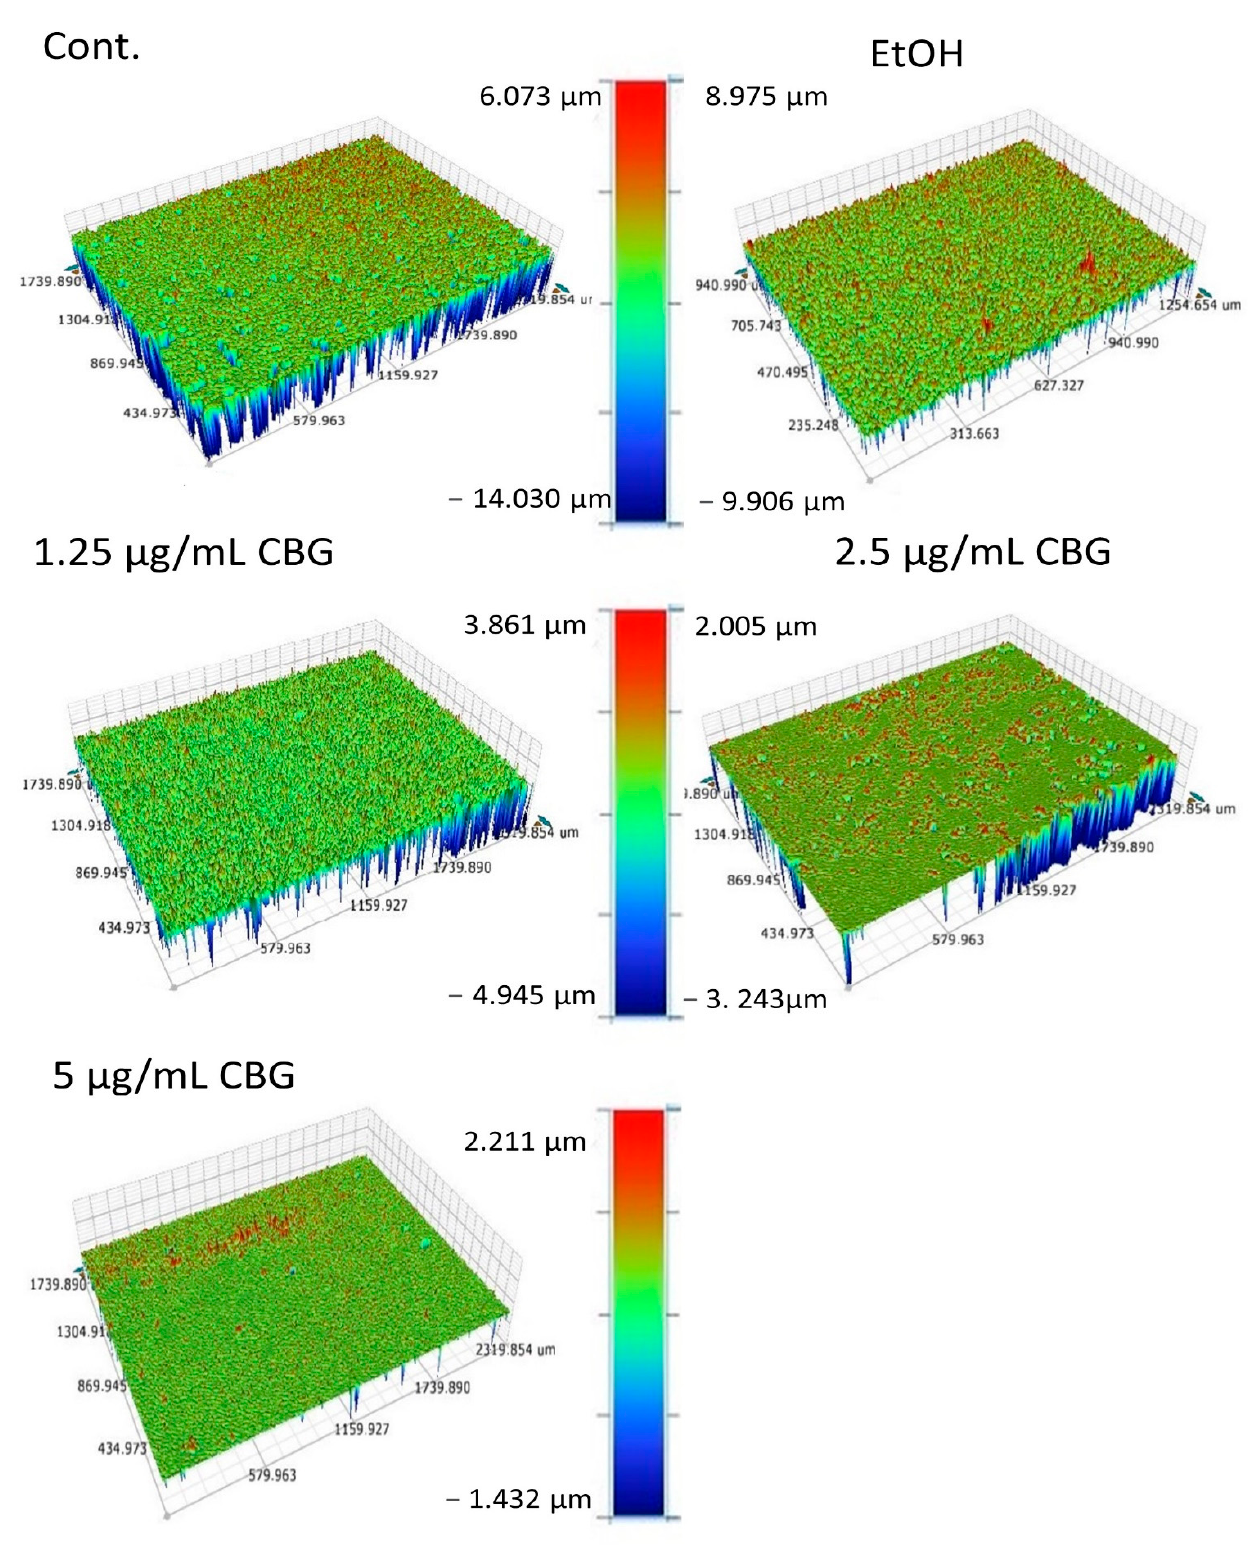
Figure 3. CBG causes a smoother S. mutans biofilm. Surface topography of untreated and CBG-treated S. mutans biofilm. Color scale denotes height and depth. The results are representative of three experiments.